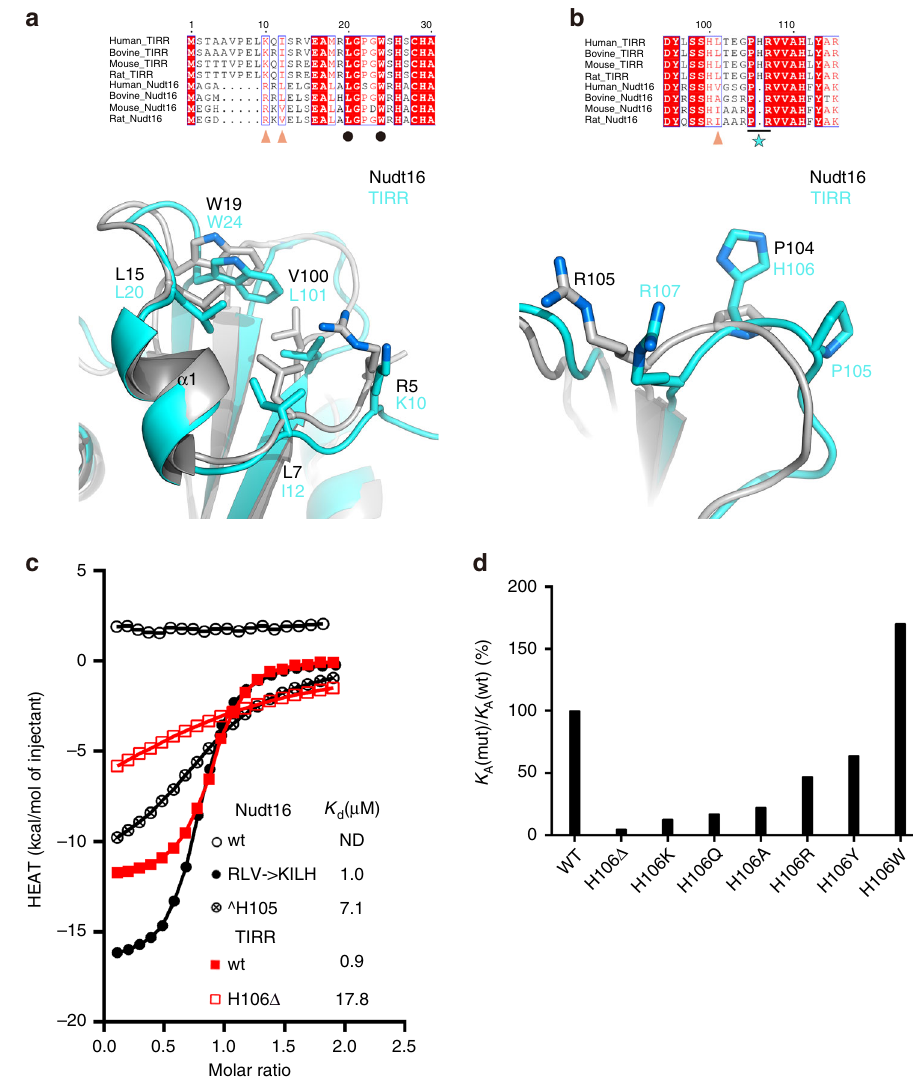
Fig. 5 TIRR residues confer a speci fi c recognition for 53BP1 Tudor. a , b Sequence and structural divergence of TIRR and Nudt16 in the N-terminal region ( a ) and the L8-loop region ( b ). Top panel: Multiple sequence alignment of TIRR and Nudt16 from human, bovine, mouse, and rat. Lower panel: Superimposed structures of TIRR (cyan) and Nudt16 (gray, PDB 3COU). TIRR residues participating in 53BP1 Tudor binding are colored in orange. Triangles and circles represent residues that are either conserved or non-conserved between TIRR and Nudt16. The blue star represents the histidine that is exclusively present in TIRR. c Isothermal titration calorimetric analysis of 53BP1 Tudor binding to wild-type or mutated TIRR (Nudt16). Representative binding results for Nudt16 and TIRR are highlighted in black and red, respectively. wt (red fi lled rectangles) and TIRR H106 Δ (red open rectangles). The binding af fi nity is shown accordingly. d Effects of TIRR H106 mutation on bindings of 53BP1 Fig. 4 TIRR regulates 53BP1 activity in vivo. a TIRR mutants disrupt the interaction with 53BP1. A total of 293T cells were transfected with plasmids encoding SFB-tagged wild-type TIRR or the TIRR mutants together with the plasmid encoding HA-tagged wild-type 53BP1. Immunoprecipitation reactions were conducted using Streptavidin-protein beads and then subjected to western blotting using the indicated antibodies. The full blot is shown in Supplementary Fig. 9. b 53BP1 mutants impair the binding af fi nity to TIRR. A total of 293T cells were transfected with plasmids encoding SFB-tagged wild- type 53BP1 or the 53BP1 mutants together with the plasmid encoding Myc-tagged wild-type TIRR. Immunoprecipitation reactions were conducted using S beads and then subjected to western blotting using the indicated antibodies. The full blot is shown in Supplementary Fig. 9. c TIRR mutants affect the stability of 53BP1. TIRR-knockout cells were reconstituted with wt TIRR or indicated mutants of TIRR. The indicated cell lines were collected and were immunoblotted with indicated antibodies. The full blot is shown in Supplementary Fig. 9. d TIRR mutants impair DNA repair function. TIRR-knockout cells were reconstituted with wt TIRR or indicated mutants of TIRR. The indicated cell lines were treated with IR and were processed for RPA immuno fl uorescence at indicated time point post IR. RPA foci were quanti fi ed (at least 400 cells were counted for each experiment). Data are represented as the mean ± s.d. ( n = 3). * p < 0.05; ** p < 0.01. e TIRR mutants sensitize the cells to ionizing radiation treatment. TIRR knock-out cells were reconstituted with wt TIRR or indicated mutants of TIRR. The indicated cell lines were treated with various doses of IR. Cell survival following irradiation was measured by clonogenic assay according to the “ Experimental Procedures. ” * p < 0.05; ** p < 0.01. f , g TIRR mutants abolish its inhibitory effect on 53BP1 recruitment at DNA-damage sites after IR. f MDA231 breast cancer cells were transfected with plasmids encoding SFB-tagged wt or mutants of TIRR. After 24 h of transfection, cells were subjected to IR. Cells were fi xed 1 h later and the immuno fl uorescence was performed with indicated antibodies. Scale bar represents 200 μ m. g Quantitative analysis of 53BP1 foci at DSBs in cells overexpressing SFB-tagged wt or mutants of TIRR. ** p < 0.01